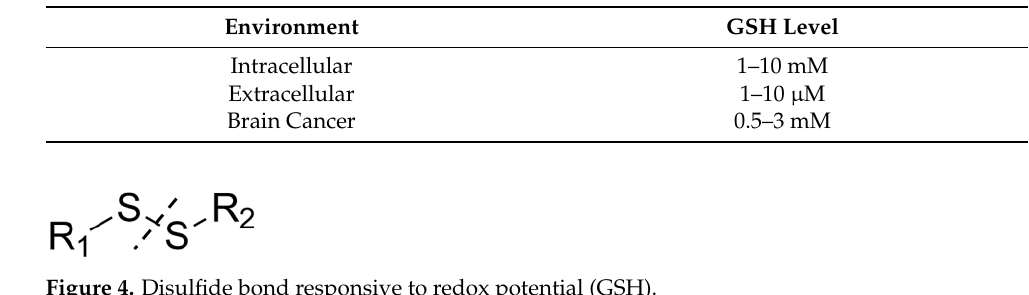
Figure 4. Disulfide bond responsive to redox potential